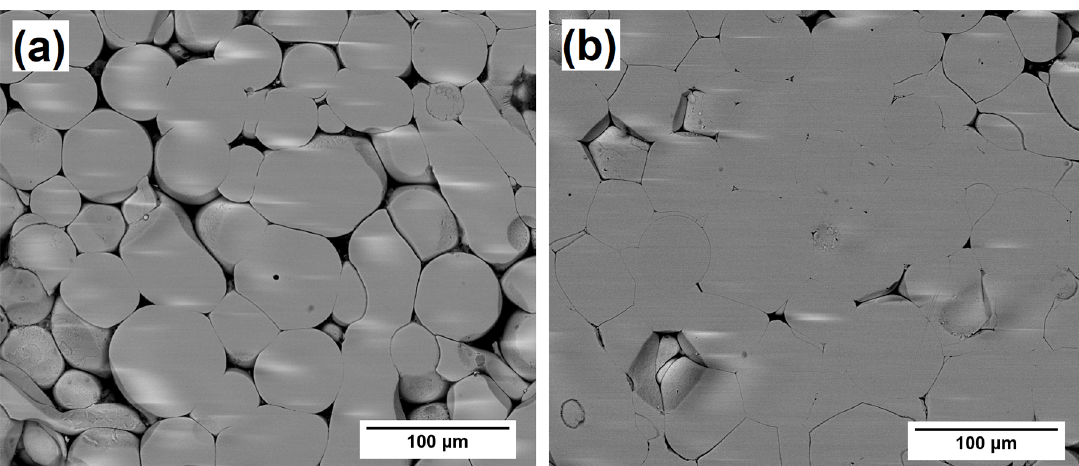
Figure 4. SEM - Backscattered Electron (BSE) micrographs of the cross section of the consolidated samples (a) C2 and (b) C3.